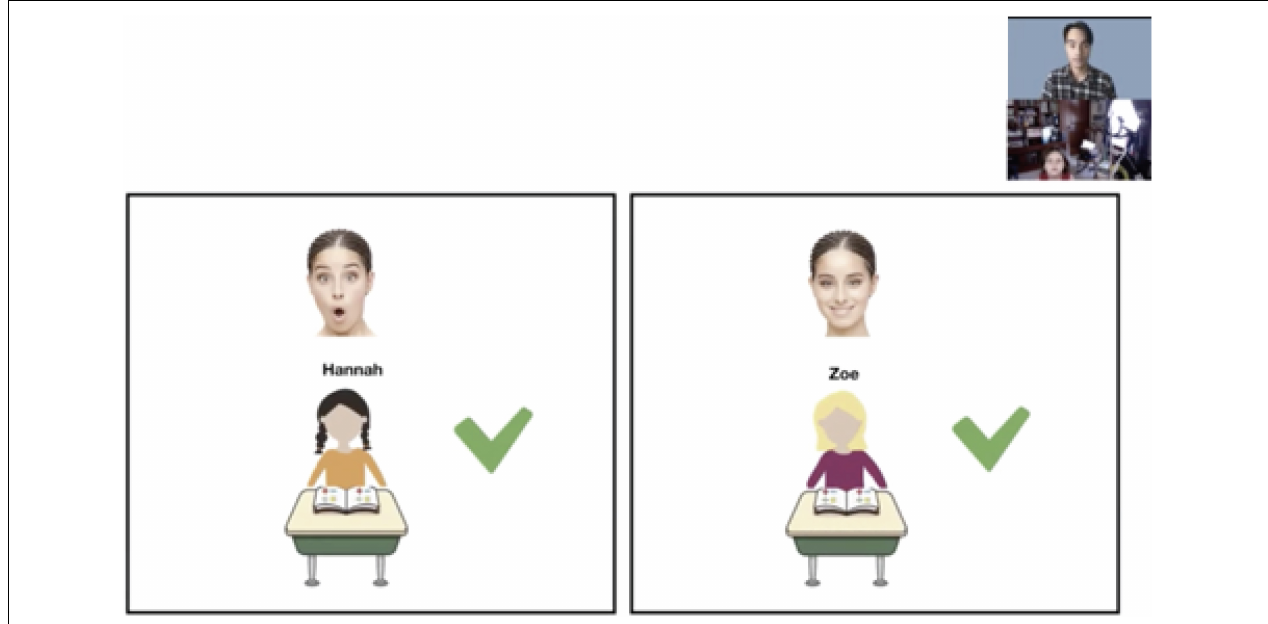
FIGURE 2 | One option for eliciting choice in Study 2. Children could be asked to choose which agent is better at math, Hannah in orange or Zoe in purple?